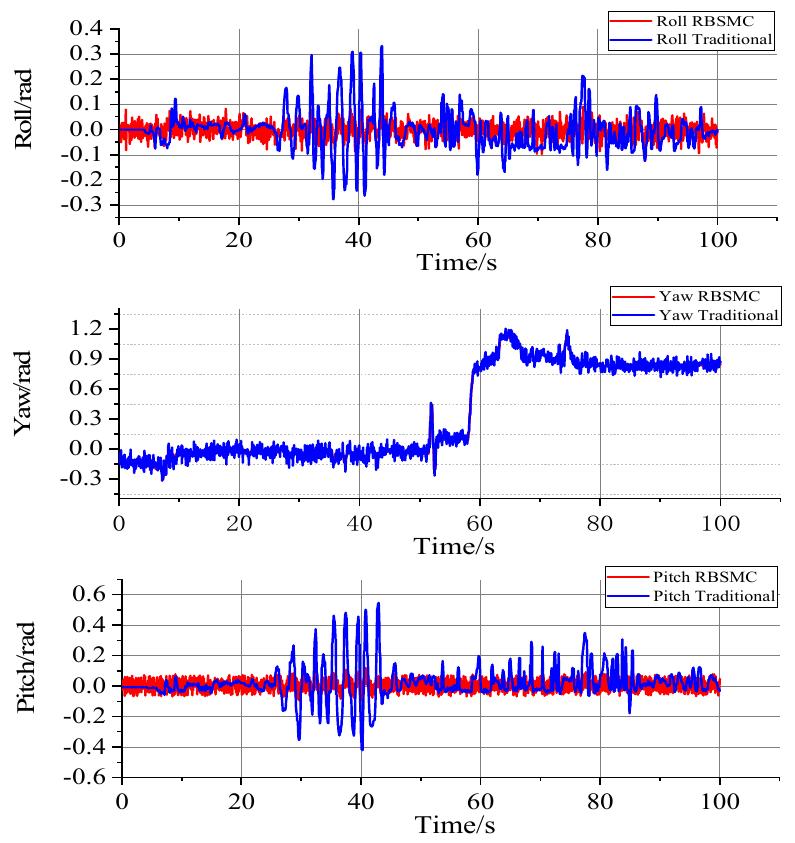
Figure 8. Traditional versus RBSMC